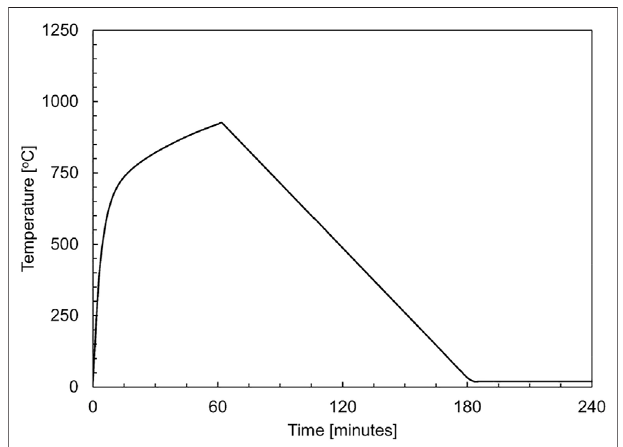
FIGURE 3 | Gas temperatures in all bays for Fire Scenario